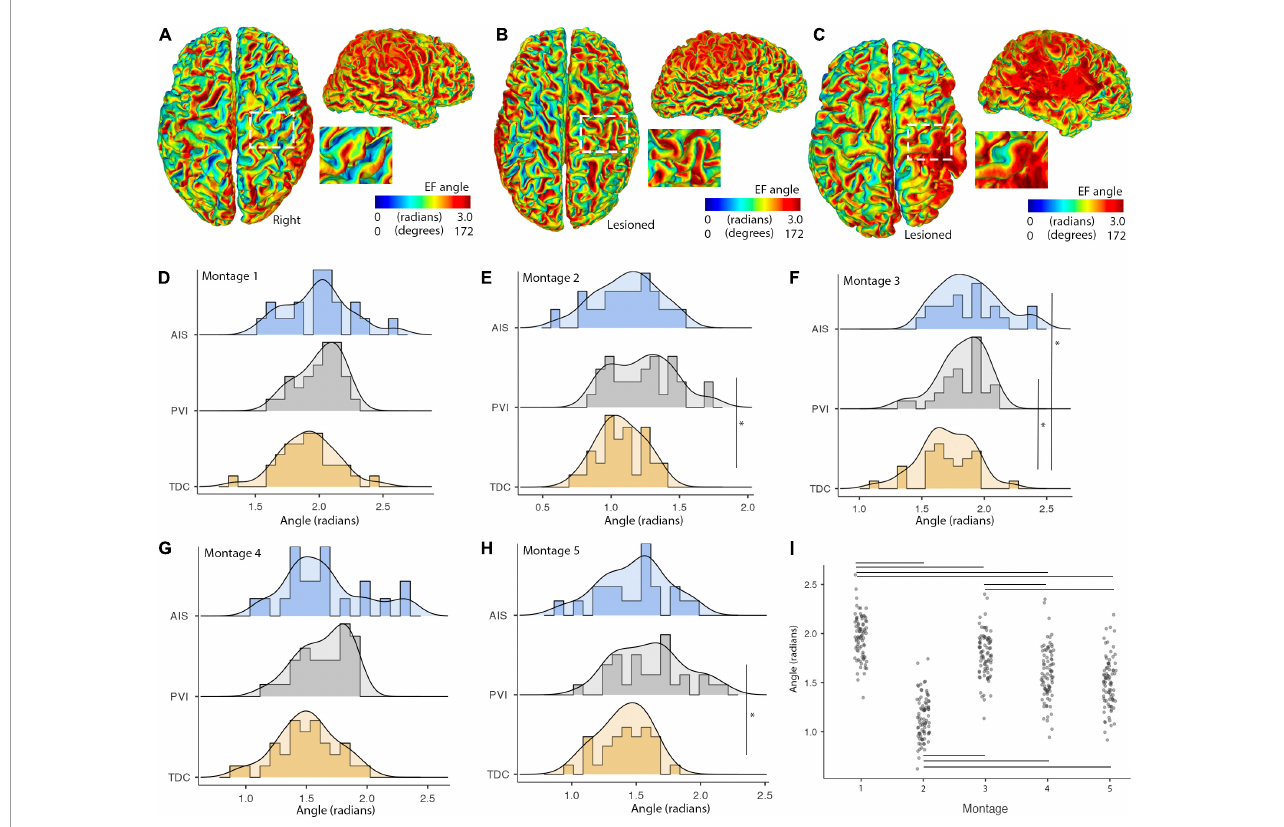
FIGURE7 Illustrations of montage- and group-specific differences in electric field (EF) angles. Individual surface maps of EF angle for montage 1 are shown for panel (A) . A TDC participant (B) . A PVI participant and (C) . An AIS participant with insets displaying pre- and post-central gyrus of M1 in the lesioned/right hemisphere for each participant. (D–H) Show distributions and group differences in EF angles across the five montages. Vertical lines show significant differences between participant groups (* p < 0.05) (I) . EF angle varied widely across montage with montage 1 showing the highest and montage 2 showing the lowest EF angle values compared to all other montages. Horizontal lines show significant differences between montages (all p -values < 0.001). AIS, arterial ischemic stroke; PVI, periventricular venous infarction; TDC, typically developing